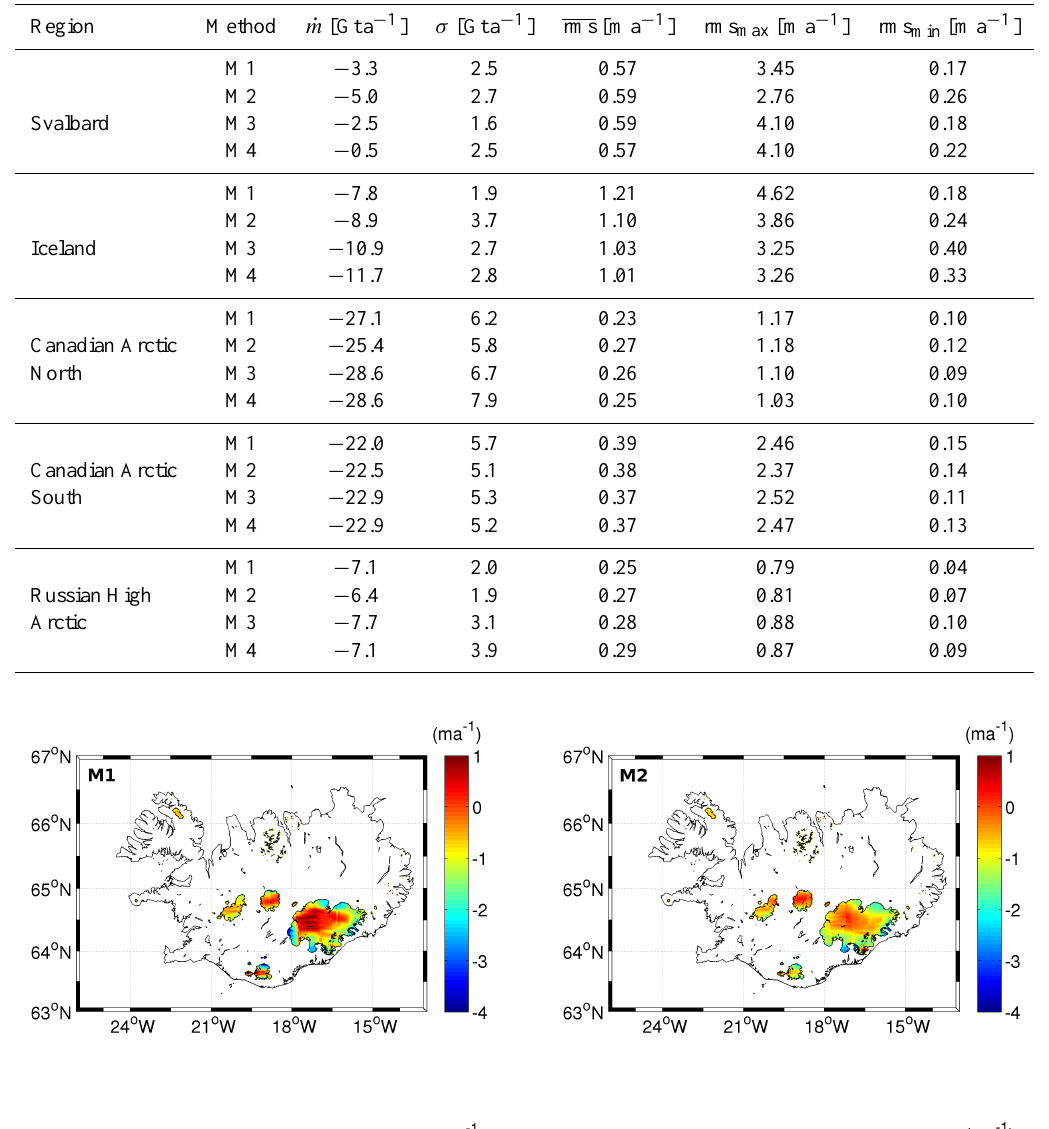
Table 3. Geodetic mass balance ˙ m from the four methods with their corresponding errors ( σ ), and their mean rms (rms), maximum rms (rms max ) and minimum rms (rms min ) from the cross-validation procedure.